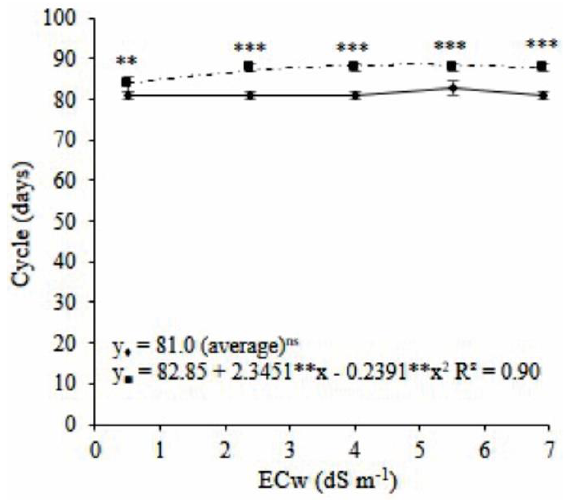
Figure 2. Regression analysis and means comparison test (Tukey, p < 0.05 and SD, n = 4) for the cycle of mini watermelon in hydroponic cultivation using a nutrient solution prepared with reject brine and different substrates. ( ♦ Coconut fiber; ■ Sand). ***, **, and ns significant at 0.001, 0.01 probability levels, and not significant, respectively.